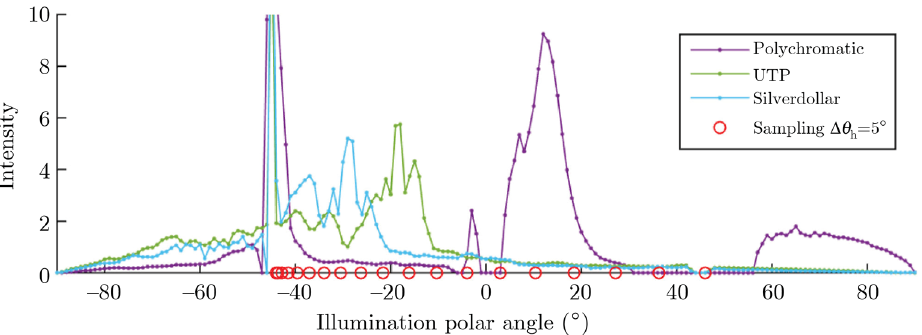
Fig. 4 Typical behavior of a high-contrast pixel for the tested coatings, for in-plane geometry with the camera at 45 ◦ and moving